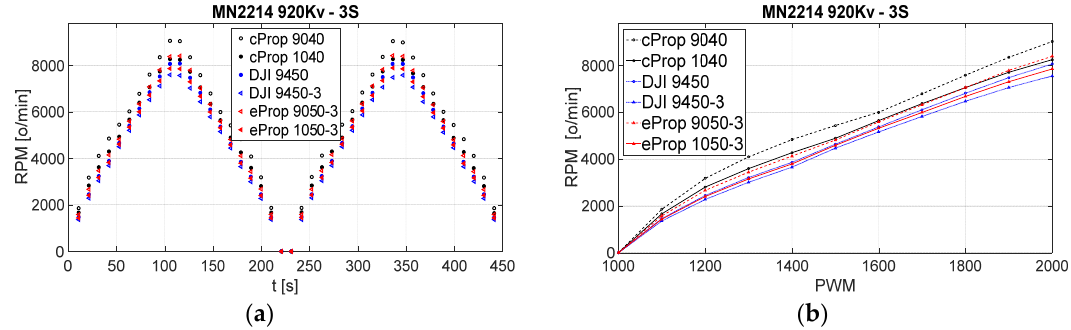
Figure 8. Rotor RPM for setup with MN 2214 BLDC motor: ( a ) raw measurement; ( b ) RPM static maps.